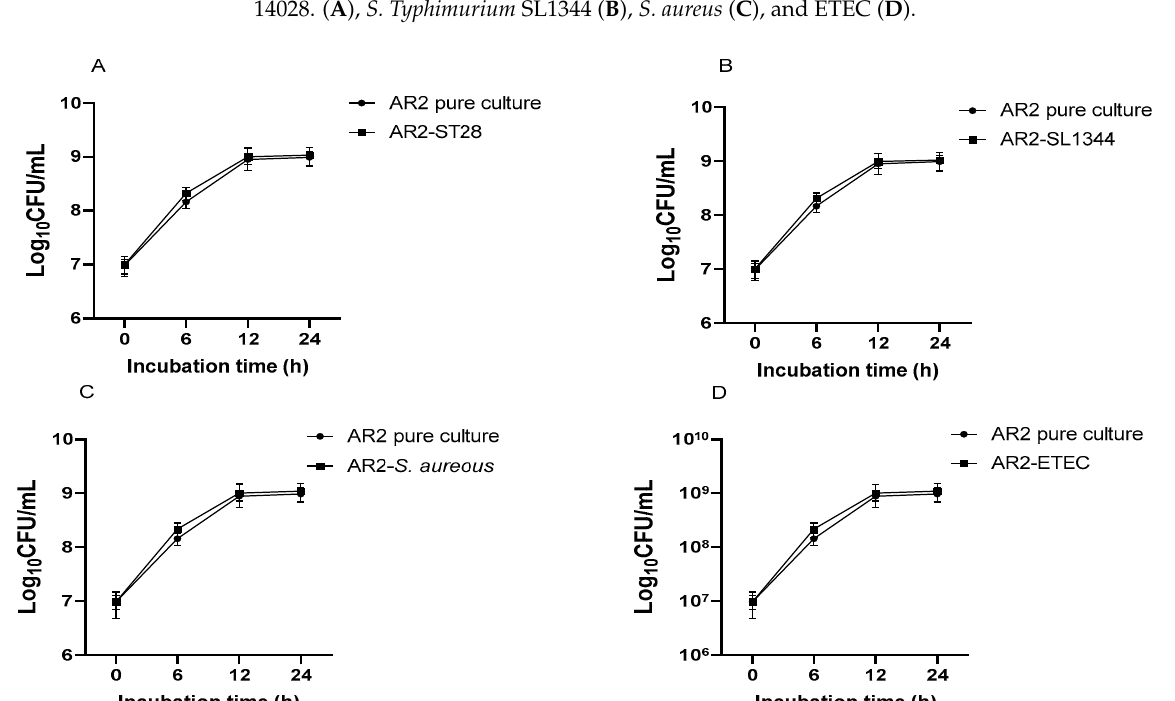
Figure 6. Growth pattern of L. acidophilus AR3 in pure culture and co-culture with S . Typhimurium ATCC14028 ( A ), S . Typhimurium SL1344 ( B ), S. aureus ( C ), and ETEC ( D ).